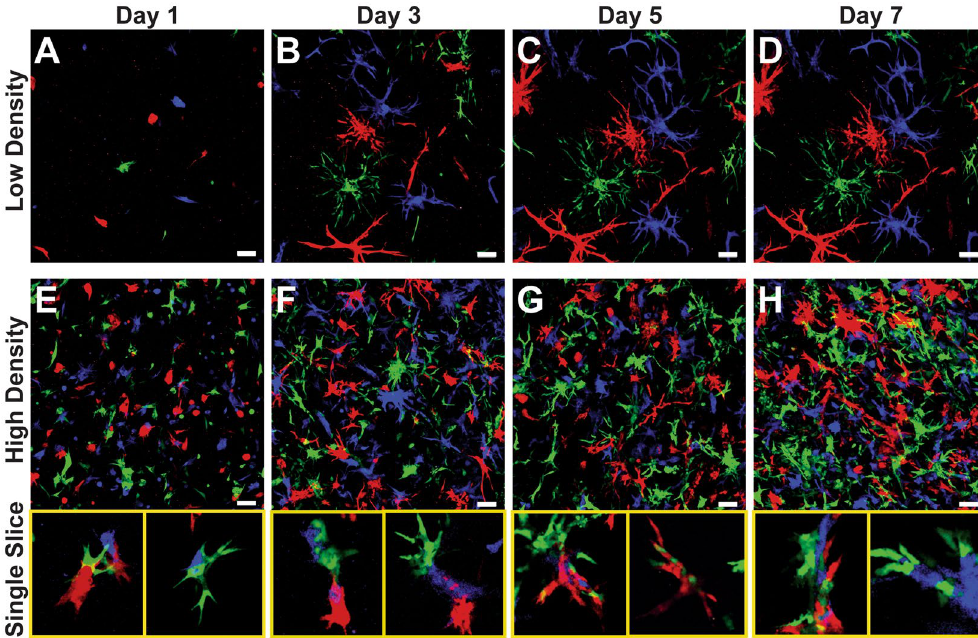
Figure 7. Duct Assembly Model Depends on Proximity. Multipoint imaging of low cell density (5e4 cells/mL) cultures ( A–D ) and high cell density (1.5e6 cells/mL) cultures ( E–H ). Low density cultures show clonal branching from single cells suspended within the gel, while multi-colored structures are apparent in high density cultures after only a single day in culture because of their close proximity. Representative single z-slices of high density cultures indicate that structures composed of two or three colors are fairly common at all time points. Scale bars = 100 μ